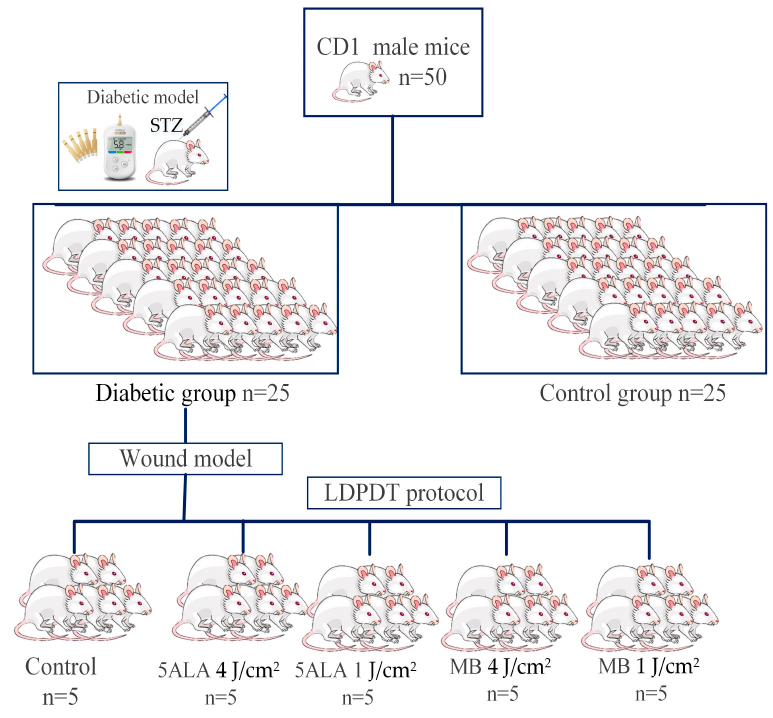
Figure 2. The experimental research design.